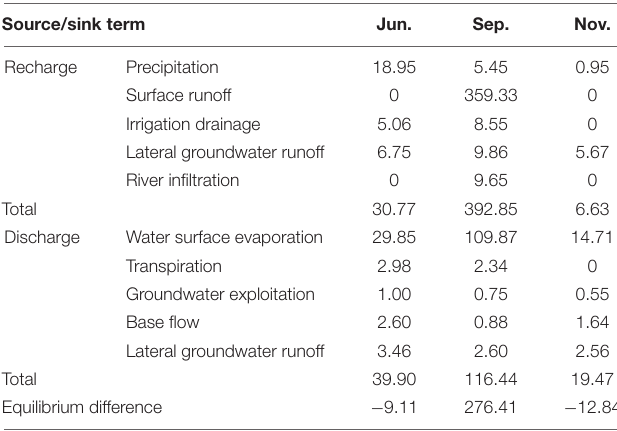
TABLE 2 | Water balance calculation results of MNNR (Unit: × 10 4 m 3